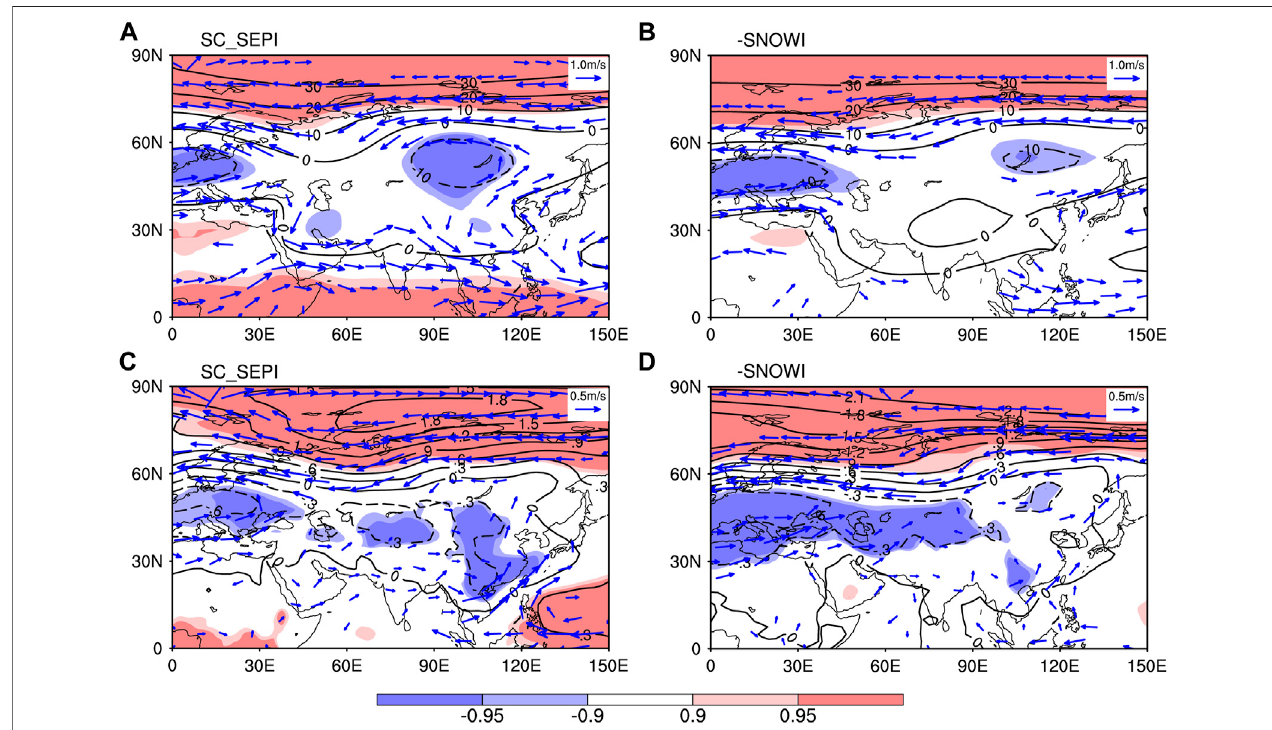
FIGURE2| Regressionsofspring (A) 200 hPageopotential height(m) and wind (ms − 1 ) and (C) sea level pressure (SLP;hPa) and 850 hPawind (ms − 1 ) against the SC_SEPI during 1979 – 2017. (B) and (D) are the same as (A) and (C) but for negative October SNOWI. Light and dark shaded regions indicate that the anomalies are signi fi cant at the 90 and 95% con fi dence levels, respectively. Wind vectors that are signi fi cant at the 90% con fi dence level are shown.